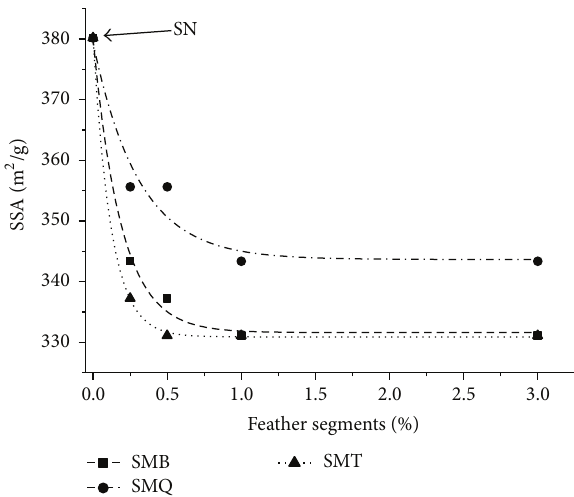
Figure 9: Specific surface areas (SSA) for the different percentages of keratin segments used as soil